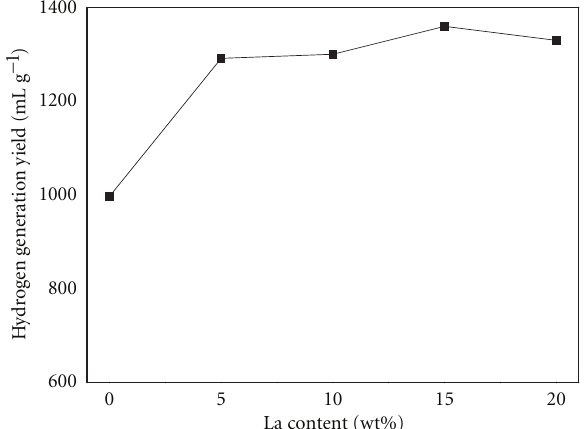
Figure 2: Relationship of hydrogen generation amount and La content at 323K.